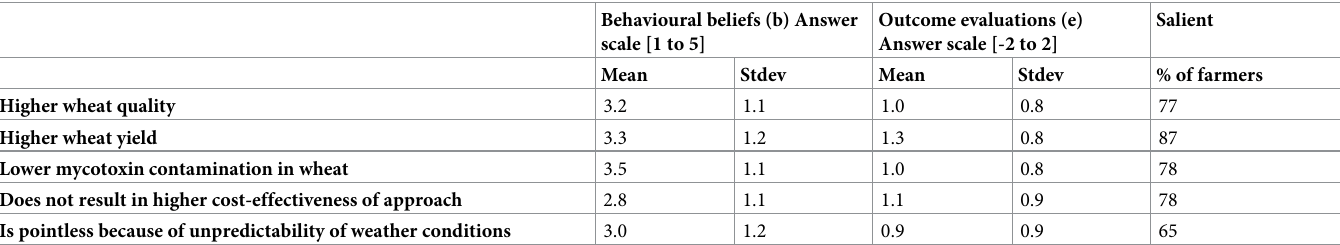
Table 3. Average score for attitudinal (ATT) beliefs and the percentage of farmers for which the belief is salient (n =